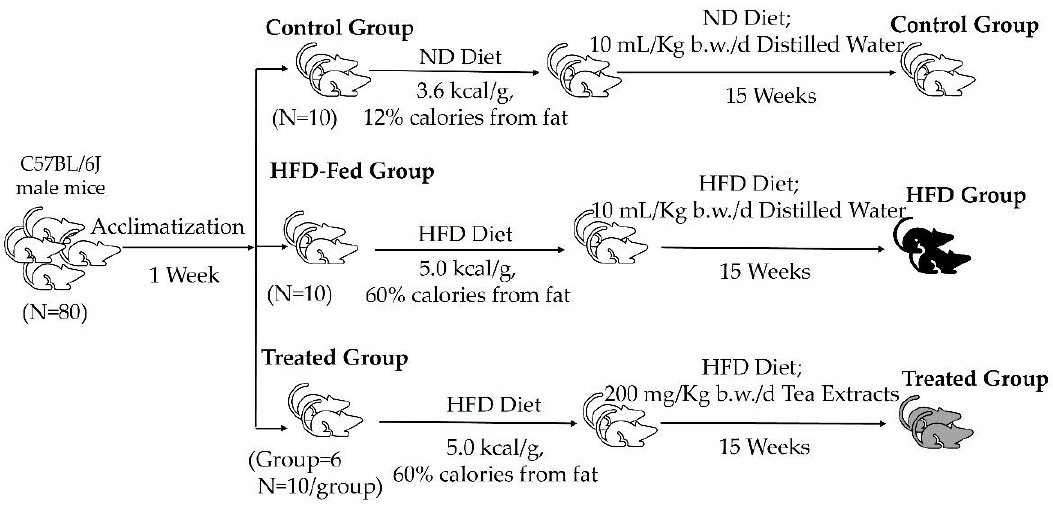
Figure 1. The animal experimental procedure. ND, normal diet; HFD, high-fat diet.